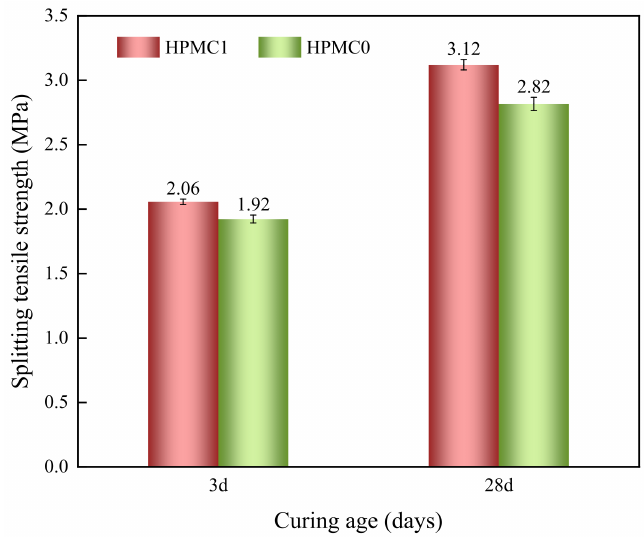
Figure 4. Splitting tensile strength of concrete with increasing